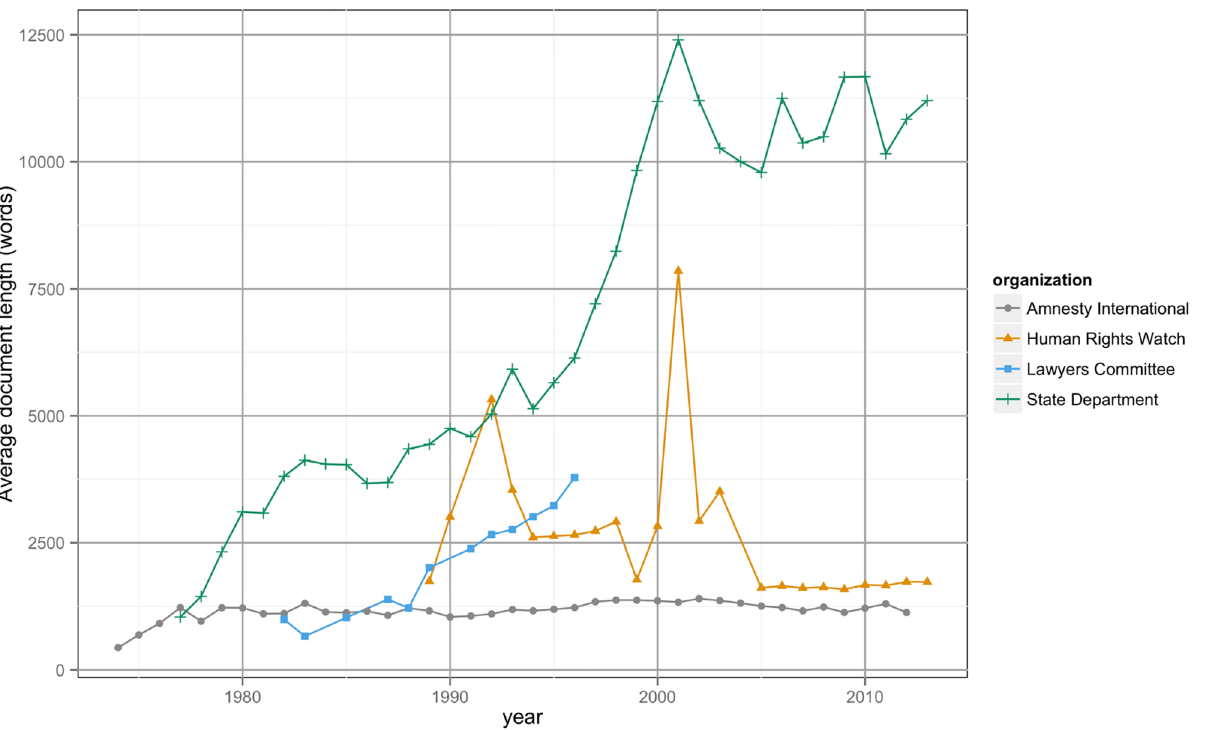
Fig 2. The average number of words used per human rights report by year. The figure shows the average number of words used per human rights report by year for Amnesty International (grey), Human Rights Watch (orange), the Lawyers Committee for Human Rights (blue), and the United States Department of State